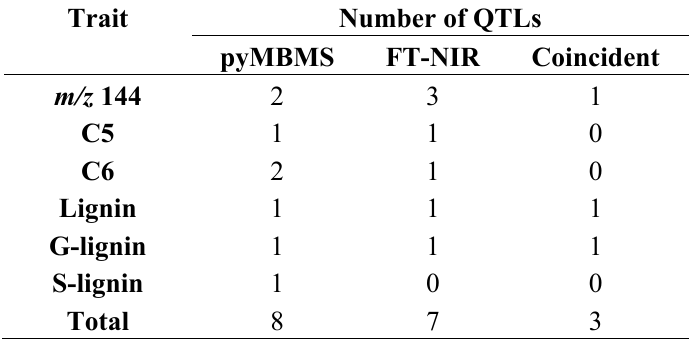
Table 5. Number of quantitative trait loci (QTLs) detected with pyMBMS and FT-NIRS for six wood chemical traits. Coincidental QTLs map to the same intervals in the genome.